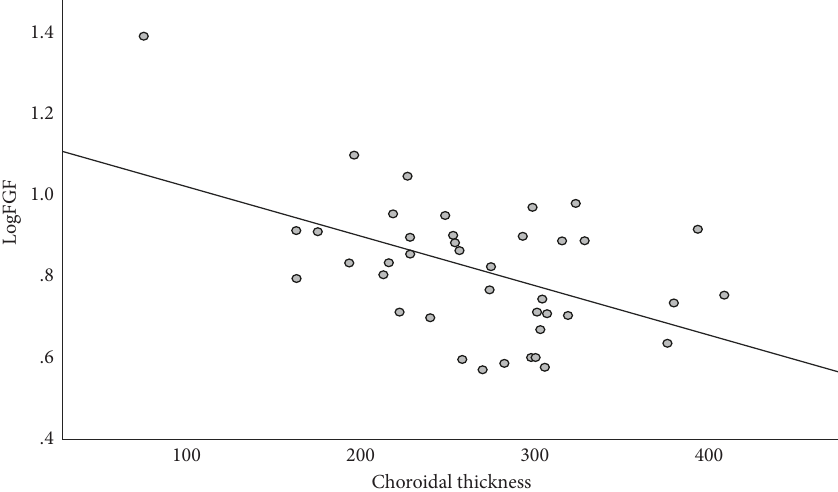
Figure 3: Correlation between aqueous humor FGF and CT in DME